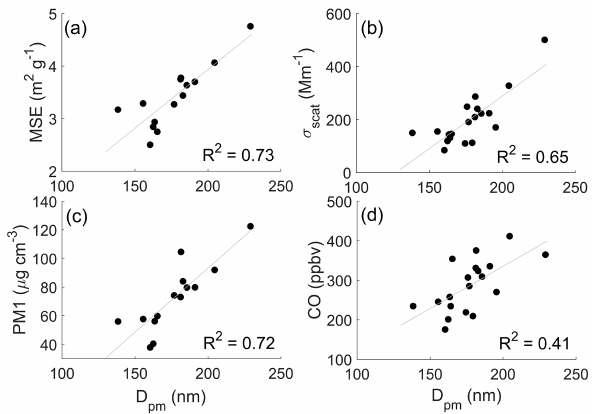
Figure 6. Scatter plots of (a) MSE, (b) σ scat , (c) PM 1 , and (d) CO vs. D pm for the BB events at MBO in the summer of 2015.